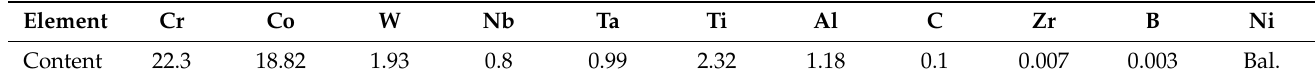
Table 1. Chemical compositions of GTD222 alloy (wt.%).